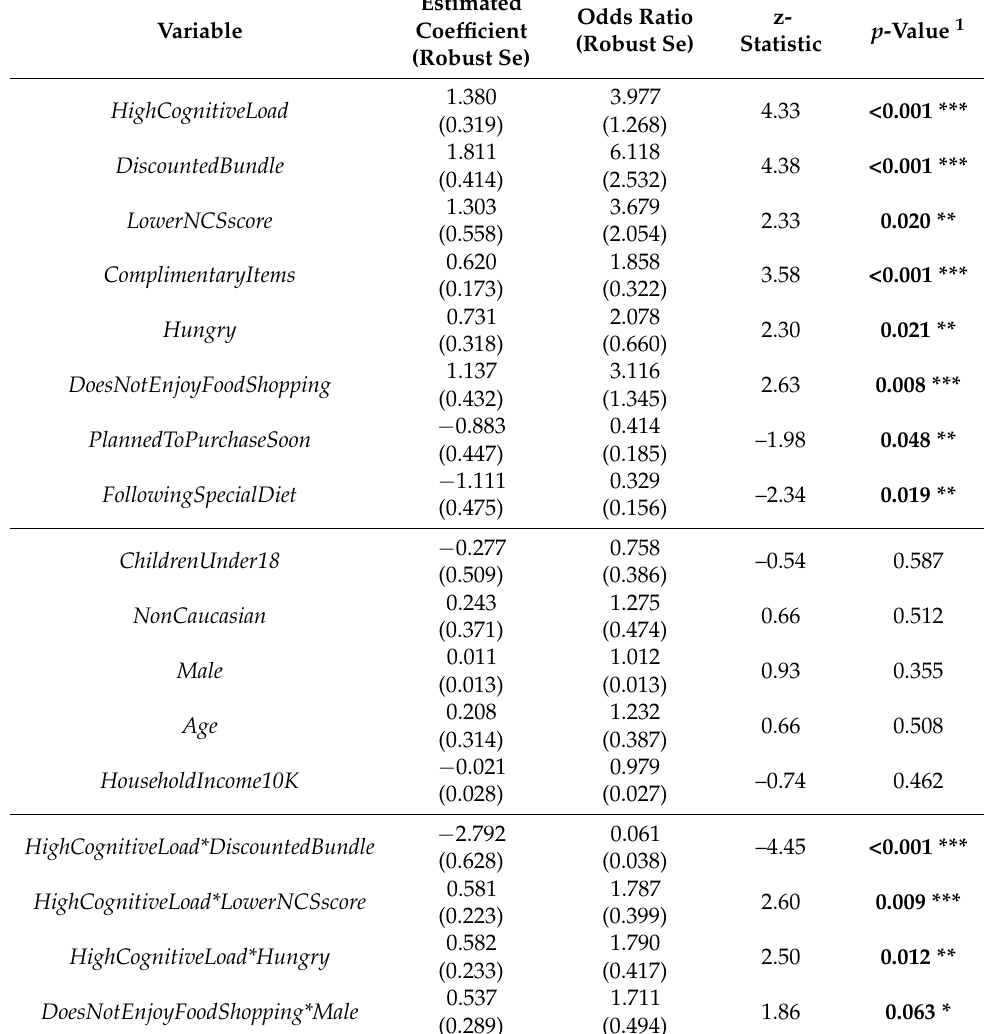
Table 6. Random Effects Binary Logit Model and Odds Ratios, Consumer Purchased Any Food Bundle in the Grocery Shopping